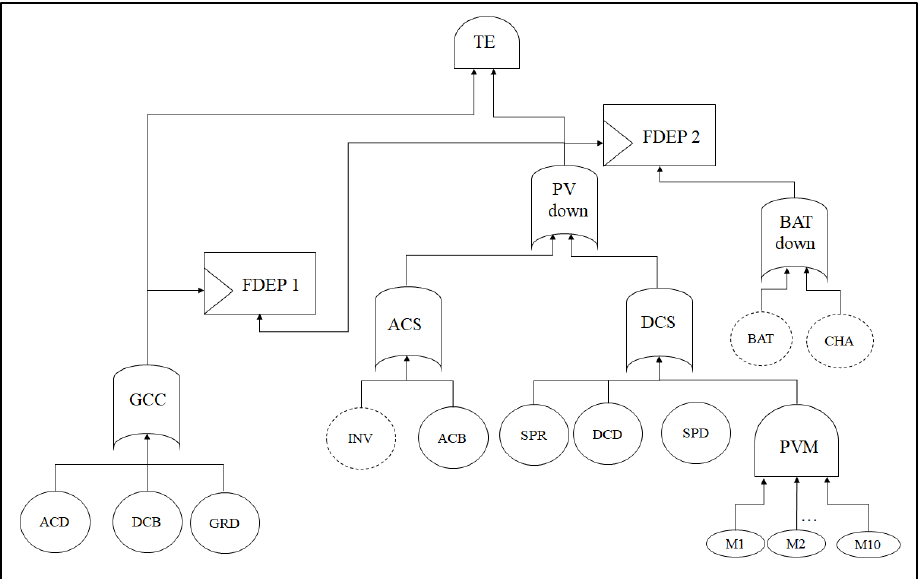
Figure 14. Dynamic fault tree of the domestic photovoltaic power plant equipped with a storage system.